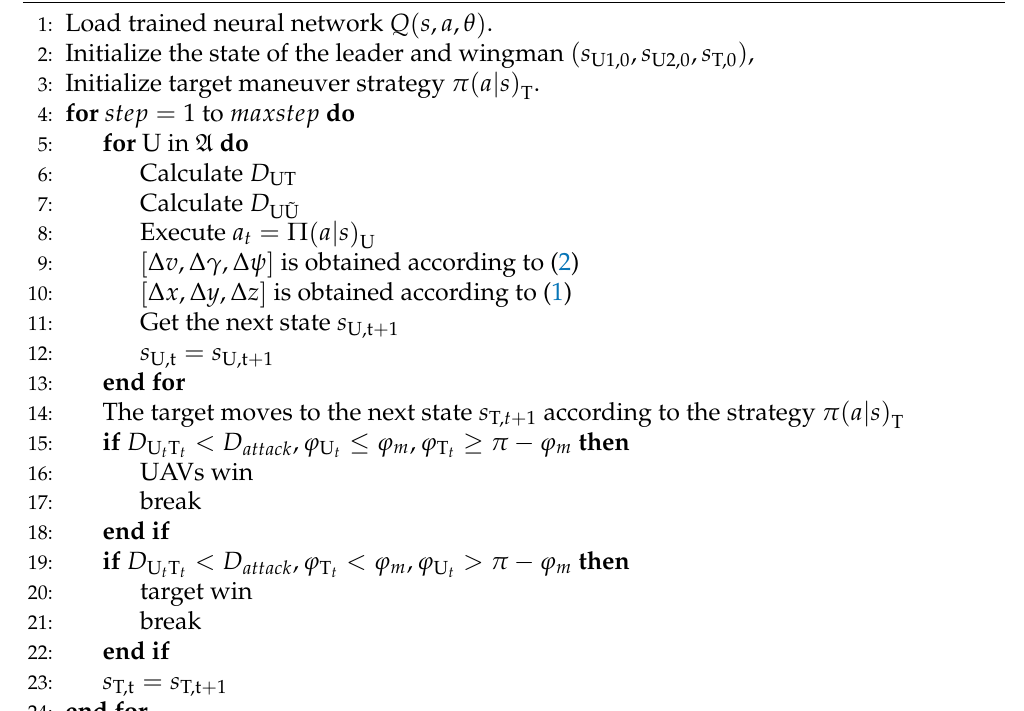
Algorithm 2 Maneuver strategy of two UAVs olive formation in air